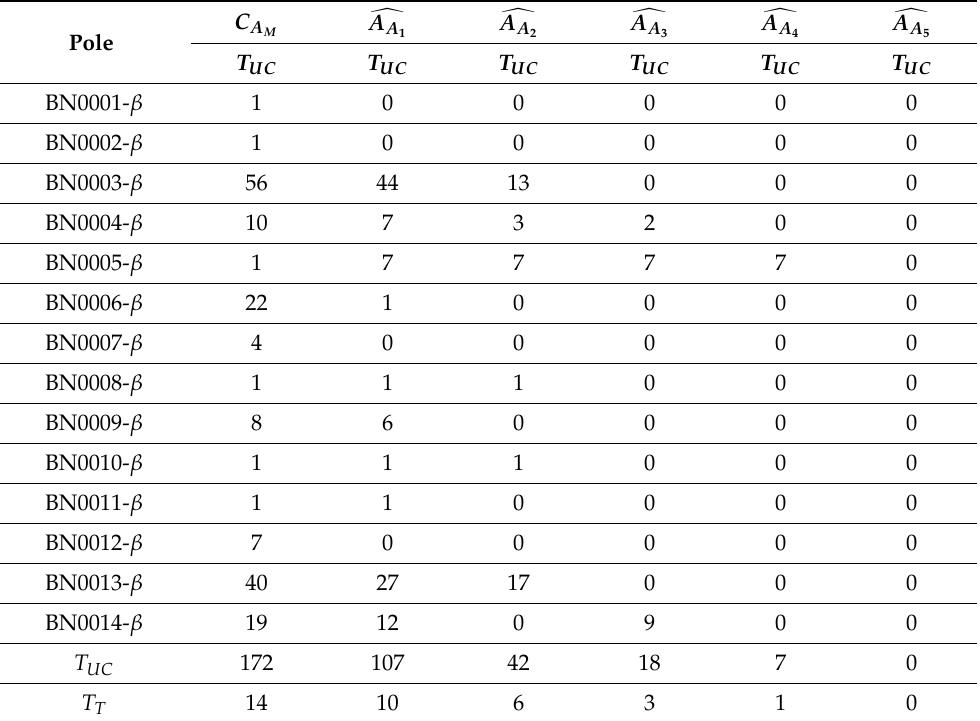
Table 14. Application of some Proposed System implemented actions in Feeder- β .